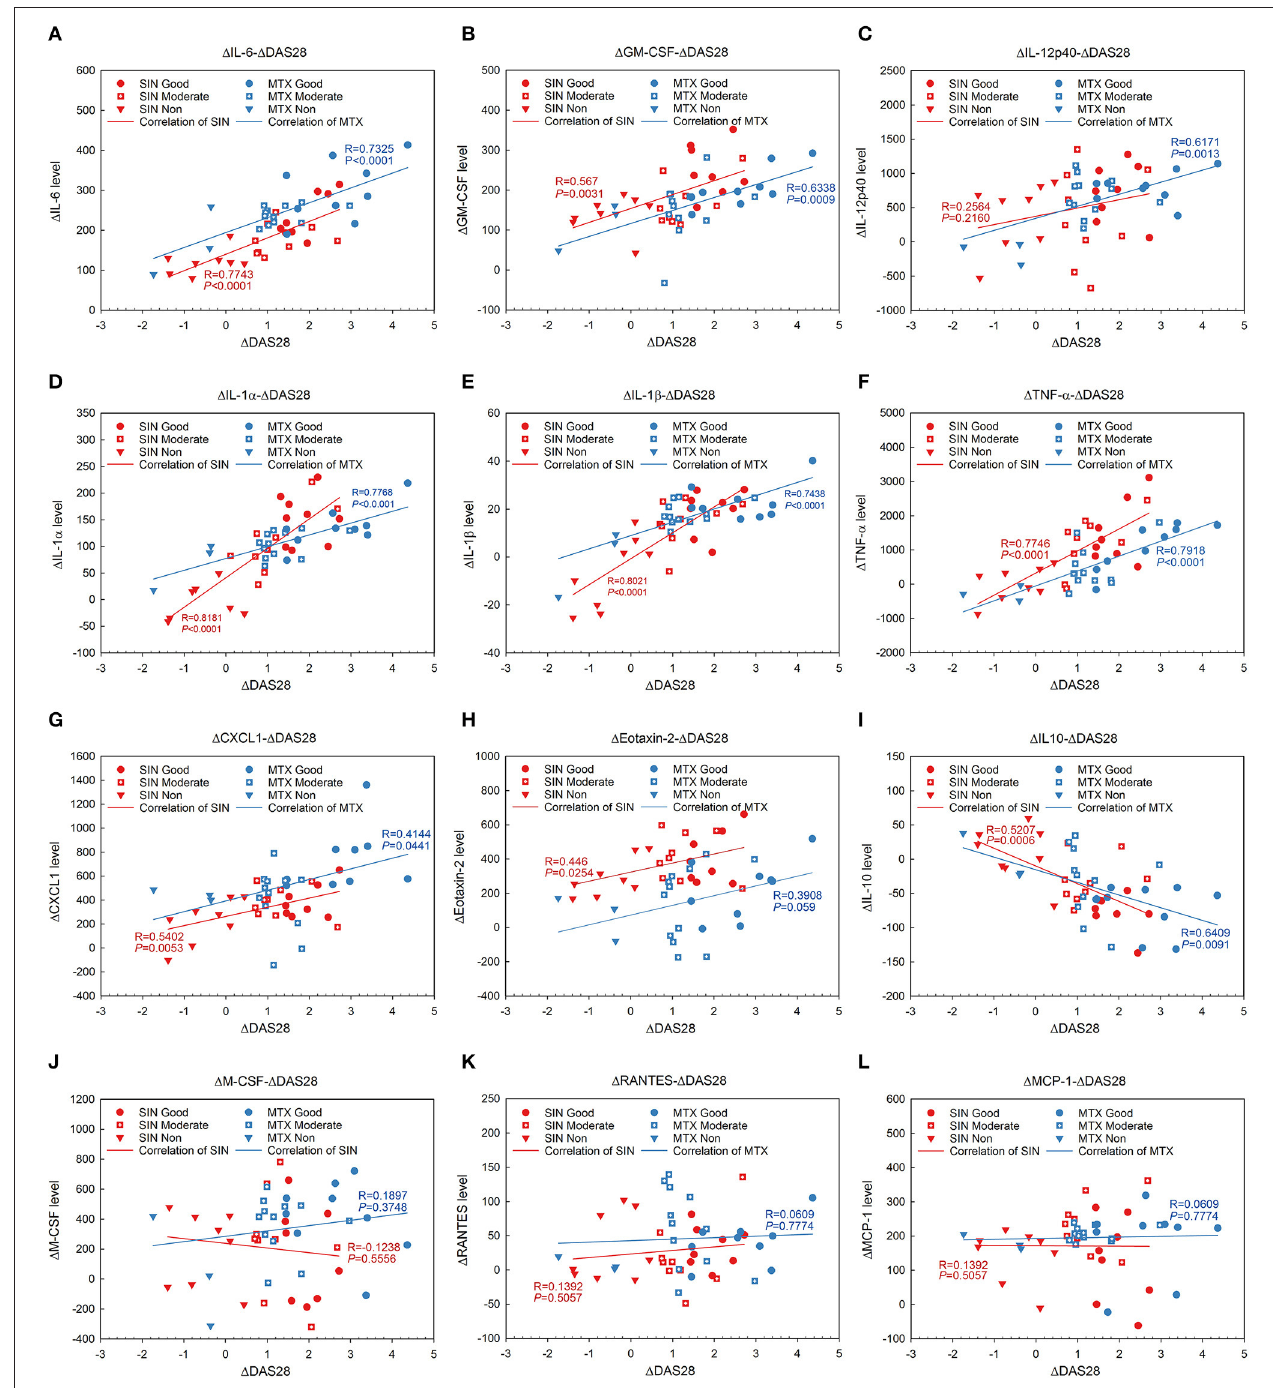
FIGURE 8 | Linear regression and coloration analysis between cytokine changes and 1 DAS28 in RA patients before and after treated with SIN or MTX. (A) IL-6, (B) GM-CSF, (C) IL12-p40, (D) IL-1 α , (E) IL-1 β , (F) TNF- α , (G) CXCL1, (H) Eotaxin-2, (I) IL-10, (J) MCSF, (K) RANTES, (L) MCP-1. Positively correlated with 1 DAS28: IL-6, GM-CSF, IL-12 p40 (SIN P = 0.216, MTX P = 0.0013), IL-1 α , IL-1 β , TNF- α , CXCL1 (GRO α ), Eotaxin-2 (SIN P = 0.0254, MTX P = 0.059); negatively correlated with 1 DAS28: IL-10; no correlation with 1 DAS28: M-CSF, RANTES, and MCP-1. r, Pearson correlation coefficient. Red, SIN therapy; blue, MTX therapy. Round dot, good responders; square with white cross, moderate responders; inverted triangle, non-responders. Red line, correlation of SIN; blue line, correlation of MTX.